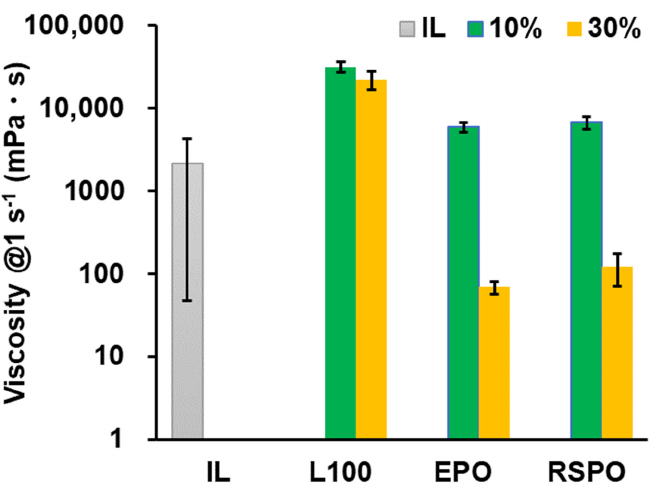
Figure 2. Viscous properties of printer inks containing an IL and different Eudragit polymers. Information on the printer ink formulations (IL, A-F) is shown in Table 1. These data represent the means ± standard deviations ( n = 3).